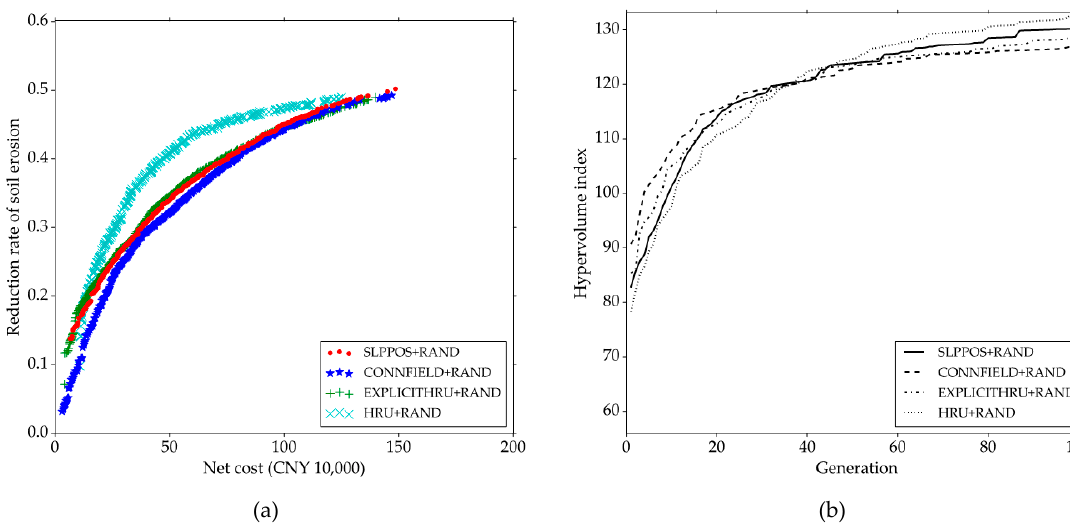
Figure 6. Comparisons among four types of BMP configuration units applied with the random configuration (RAND) strategy: ( a ) near-optimal Pareto solutions of the 100th generation and, ( b ) the hypervolume index with generations.